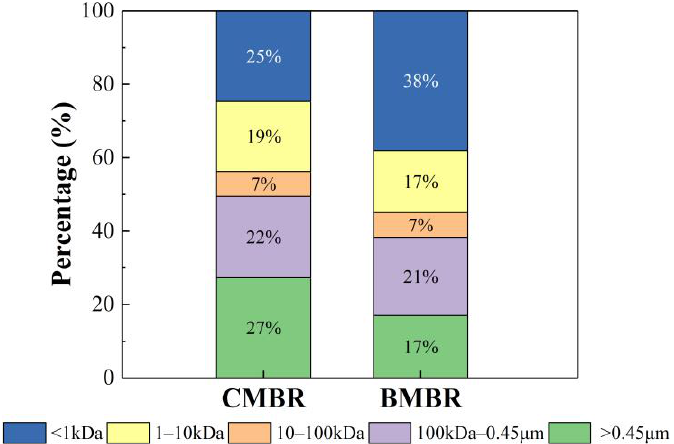
Figure 3. 3D-EEM fluorescence spectra of SMP ( A , B ) and EPS ( C , D ) in the conventional MBR (CMBR) and biochar MBR (BMBR).